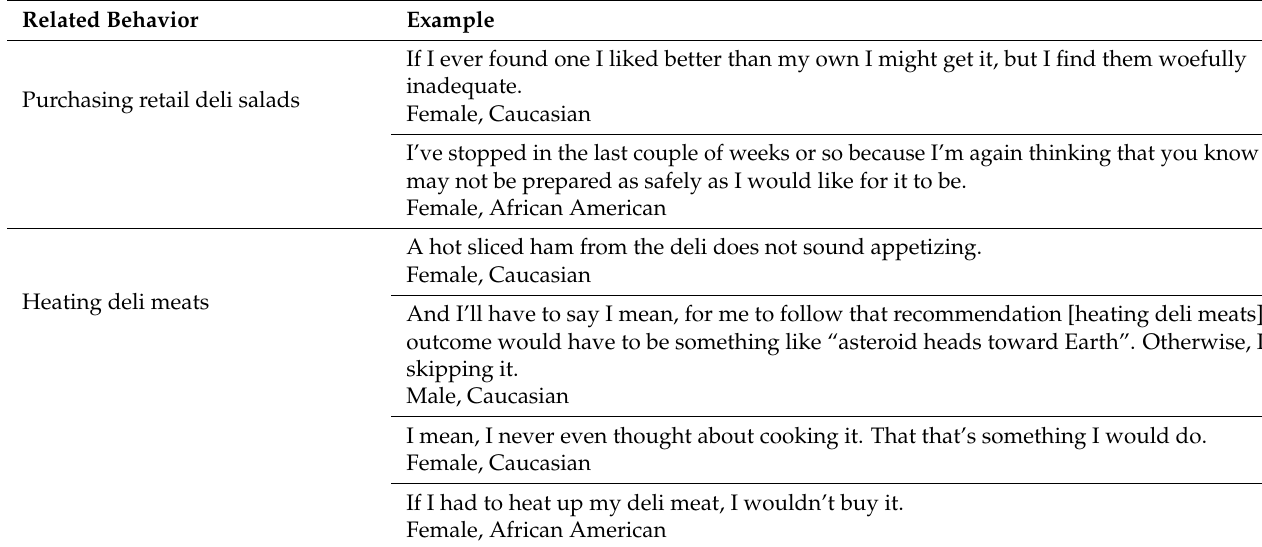
Table 4. Food handling behaviors related to ready-to-eat foods, with supporting quotes from the focus group